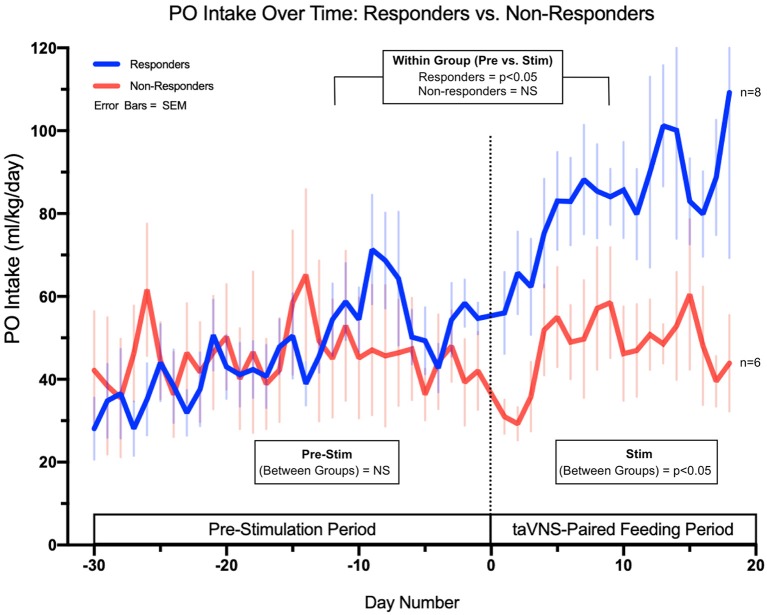
Daily PO intake feeding volumes in ml/kg/day for both responders (full PO feeds without G-tube) and non-responders (G-tube placement). The data demonstrate no significant difference in feeding trajectories between groups in the pre-stimulation phase but significant differences in trajectories between responders and non-responders upon initiation of taVNS-paired feeding.